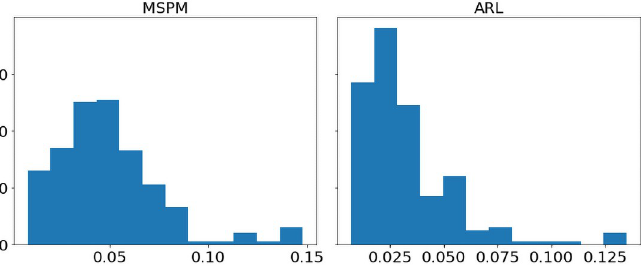
Fig 10. For portfolio(b), histograms of MSPM and ARL’s 5-day RstdDRR depict right-skewed distributions.